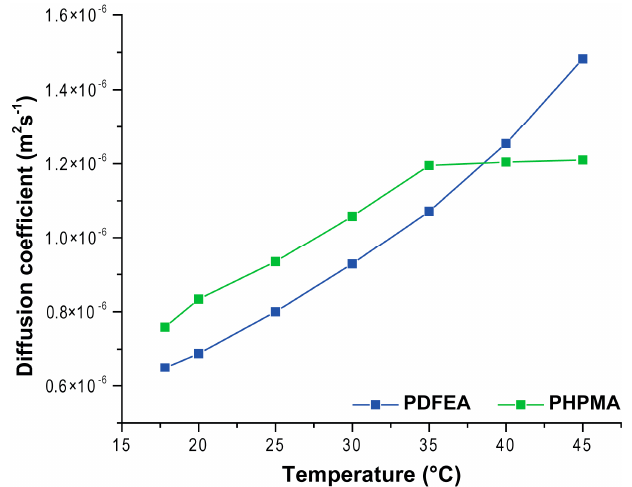
Figure 9. Self-diffusion coefficients determined for HF polymer and its blocks (PDFEA, blue , F5; and PHPMA, green , H4) as a function of